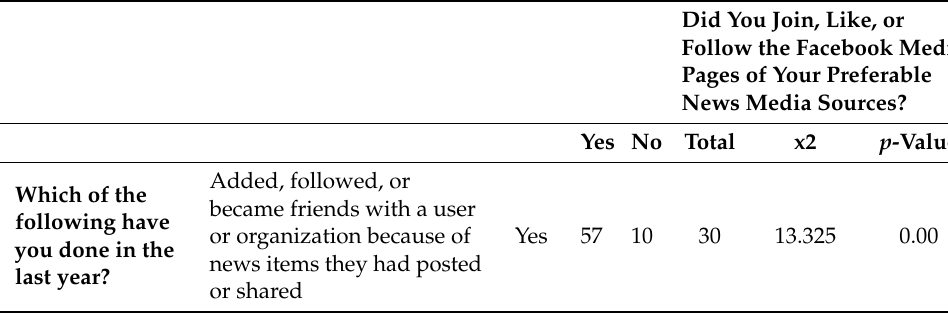
Table 7. Correlation between interactions in Facebook platform.